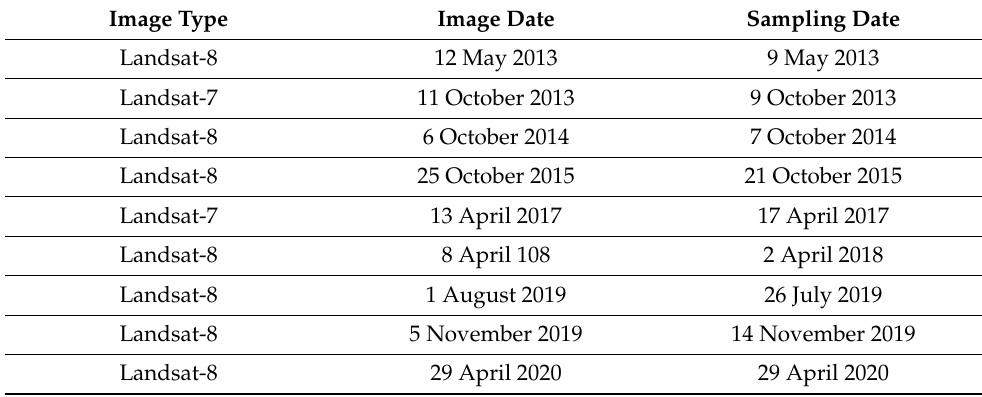
Table 1. Image type and dates of image acquisition and in situ